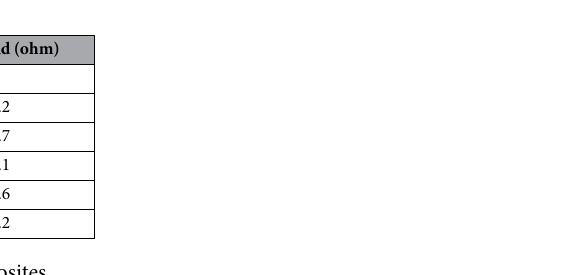
Table 3. EIS analysis of bare MoS 2 and